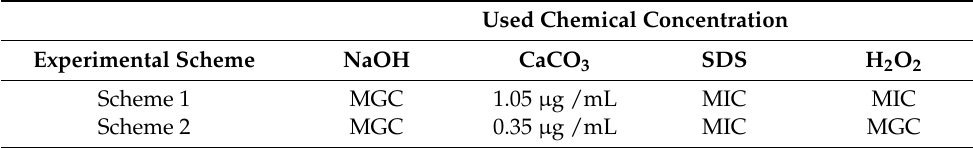
Used Chemical Concentration